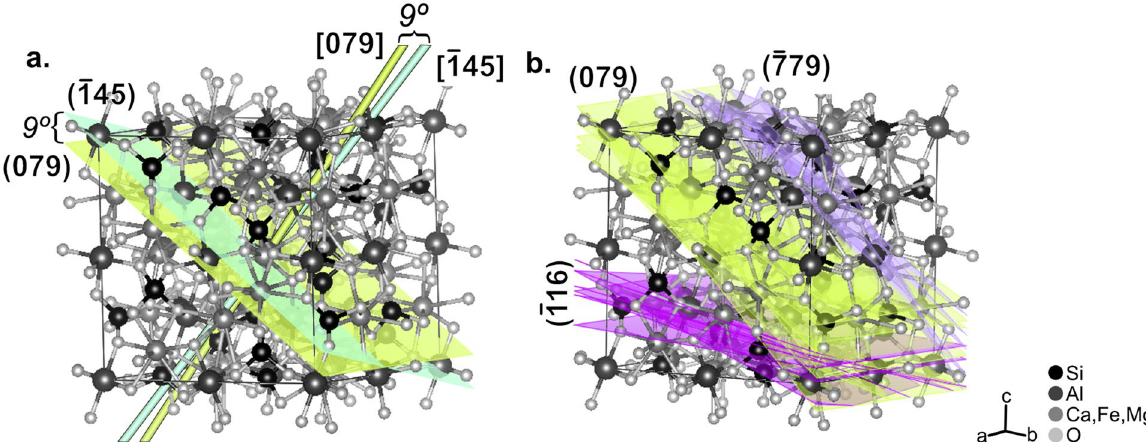
− 1 4 5 ] gt crystal direction (teal − 1 1 6 ) (pink), (0 7 9)